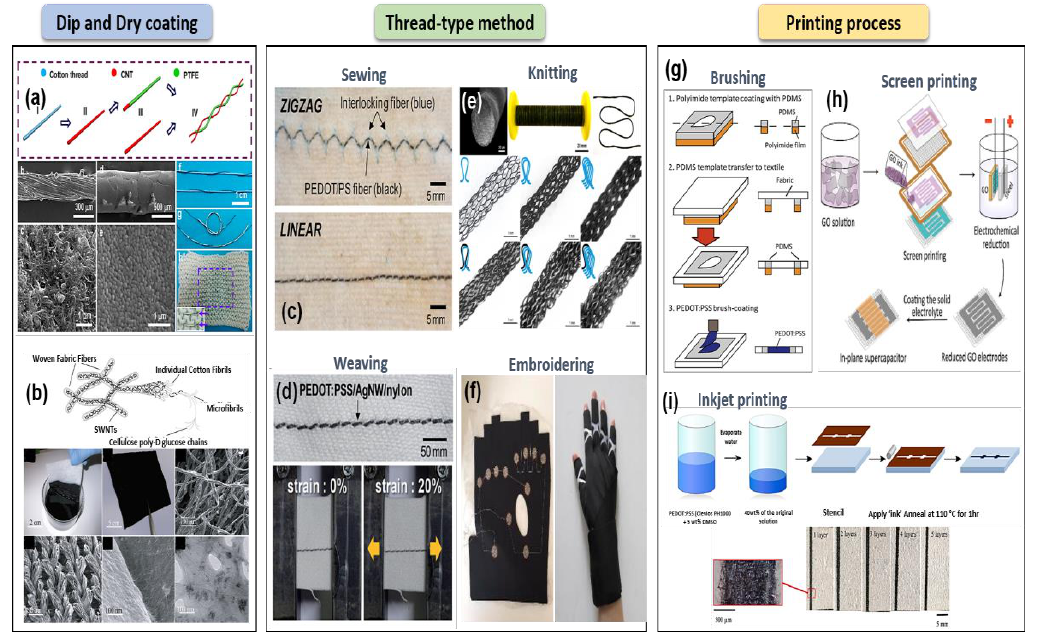
Figure 6. Fabrication technologies for textile-based wearable sensors. Dip and dry coating; ( a ) fabrication of fiber-based electronics with CNT-coated cotton thread (CCT) using a dipping and drying process (reproduced with permission [103] copyright 2014, American Chemical Society). ( b ) The SWCNT-coated woven polyester fabric using an extremely simple dipping and drying process (reproduced with permission [104] copyright 2010, American Chemical Society). ( c ) Optical images of zigzag- and linear-type PEDOT/PS fiber embedded fabrics by sewing method (reproduced with permission [115] copyright 2017, American Chemical Society). ( d ) Woven sensor fabric fabricated by weaving process (reproduced with permission [116] copyright 2017, Royal Society of Chemistry). ( e ) PU/PEDOT:PSS fibers co-knitted with a commercial Spandex yarn using knitting method (reproduced with permission [119] copyright 2015, American Chemical Society). ( f ) Textile-based smart gloves realized by the embroidering method (reproduced with permission [120] copyright 2017, Informa UK Limited). Printing process; ( g ) schematics of the fabrication process of brush-painted PEDOD:PSS electrode on knitted fabrics using PDMS-made stencil (reproduced with permission [123] copyright 2015, Nature Publishing Group). ( h ) Screen-printed rGO electrode on woven cotton fabrics through the strong chemical interaction between GO and cotton fibers (reproduced with permission [124] copyright 2017, IOP Publishing). ( i ) Patterning PEDOT:PSS on PET nonwoven fabric using inkjet printing and sponge stencil (reproduced with permission [126] copyright 2016, American Chemical Society).